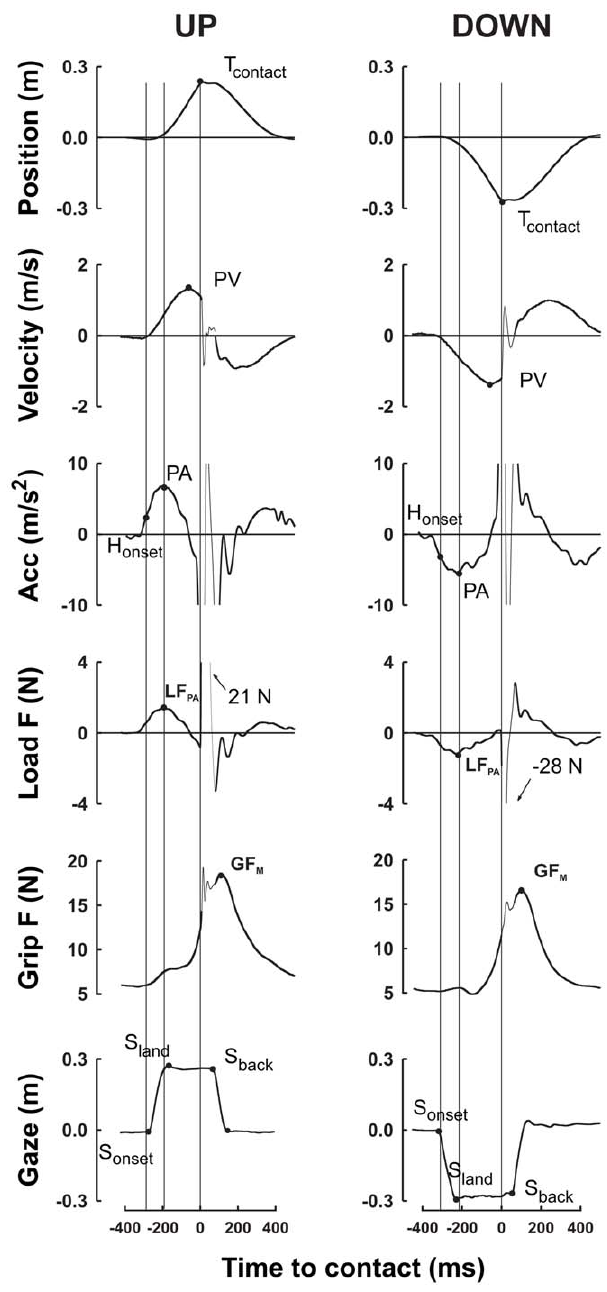
Figure 1. Typical collisions in microgravity. Records of a single collision upwards (left column) and downwards (right column). The following traces are shown as a function of time: vertical position, velocity and acceleration of the object, load and grip forces, and the vertical gaze position. The left, middle and right cursors are aligned with hand onset (H onset ), peak acceleration (PA) and contact with the target (T contact ) respectively. PV: peak velocity; LF PA : load force at peak acceleration; GF M : peak grip force; S onset , S land and S back : saccade to and arrival on the target, saccade onset back to home position.